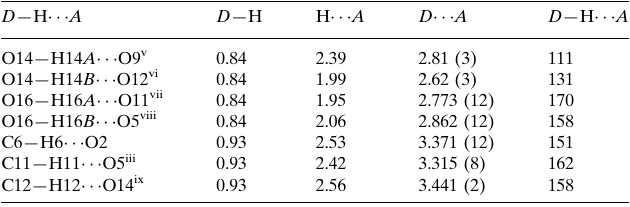
Hydrogen-bond geometry (A˚ , (cid:3)